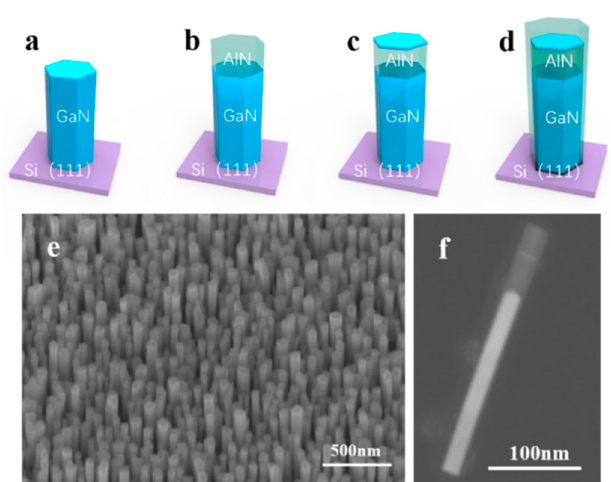
Figure 1. ( a – d ) Schematic illustration of the epitaxial growth of catalyst-free GaN / AlN dot-in-nanowire core–shell structure on a Si substrate. ( a ) GaN nanowire template grown on Si(111). ( b ) Formation of the high-temperature grown AlN barrier. ( c ) GaN dot with a thickness of 1–2 nm grown on AlN. ( d ) Formation of the low-temperature grown AlN barrier and shell. ( e ) A 45 ◦ tilted SEM image of a typical GaN / AlN dot-in-nanowire sample. ( f ) High-angle annular dark field scanning transmission electron microscopy (HAADF-STEM) image of a typical single nanowire.